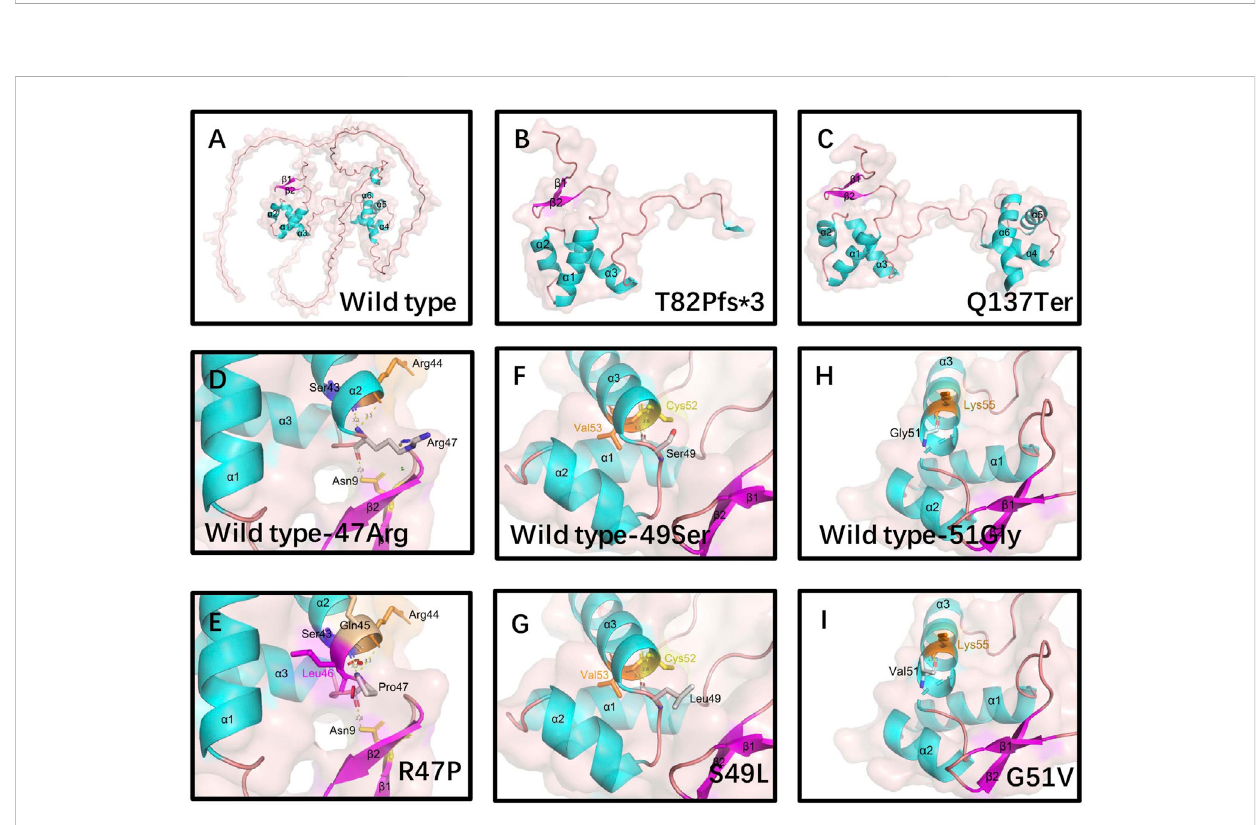
FIGURE 3 Structural analysis of wild-type and variants of PAX9 proteins. (A) wild-type PAX9 protein, (B-C) variant PAX9 p.T82fs*3 and p.Q137Ter protein. Hydrophobic Pro47 (E) introduces a Van der Waals clashes with Gln45 and Leu46(red disc) when compared with wild-type positively charged Arg47 (D) . Hydrophilic residue Ser49 (F) changed into a hydrophobic residue Leu49 (G) . Hydrophilic residue Gly51 (H) changed into hydrophobic Val51 (I)